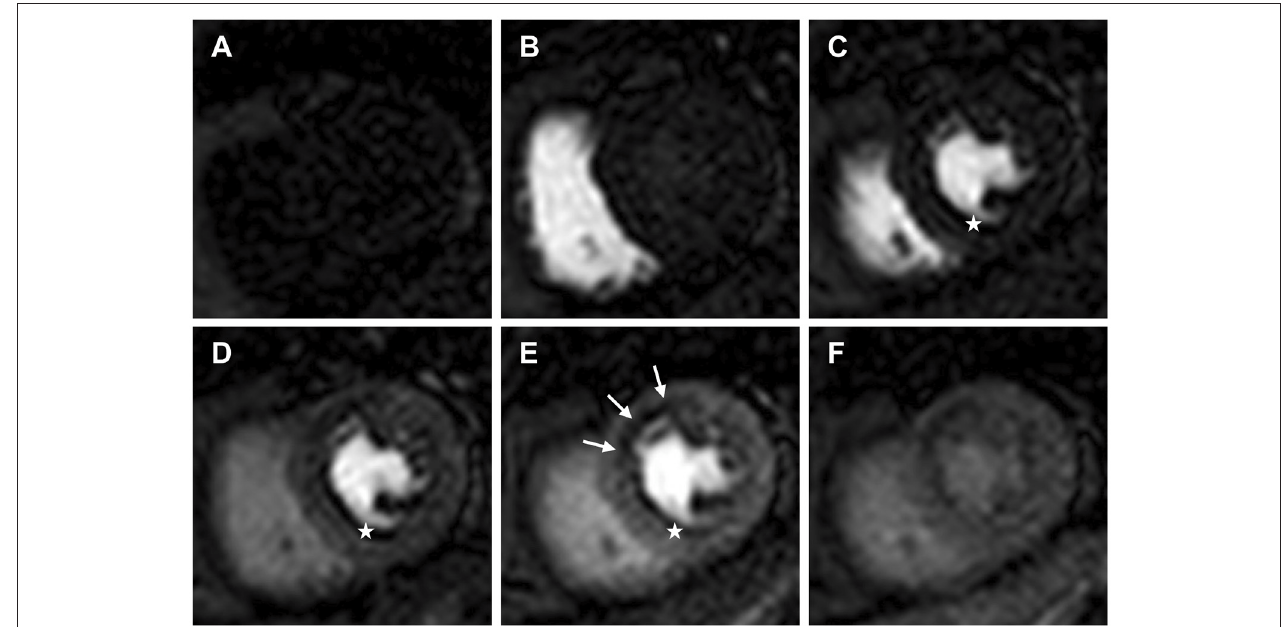
FIGURE 1 | Dynamic contrast enhanced perfusion CMR tracks and displays the first passage of an injected contrast agent bolus through the heart. Mid ventricular slice (A) pre-contrast arrival; (B) contrast arrival in the right ventricle; (C) contrast arrival in the left ventricle (LV); (D) contrast arrival in the LV myocardium; (E) maximal myocardial contrast between remote myocardium and the subendocardial region of relative hypoperfusion (white arrows); (F) second pass and redistribution of the contrast agent. White stars identify a dark rim artefact, which can be seen on arrival of contrast in the LV prior to myocardial contrast